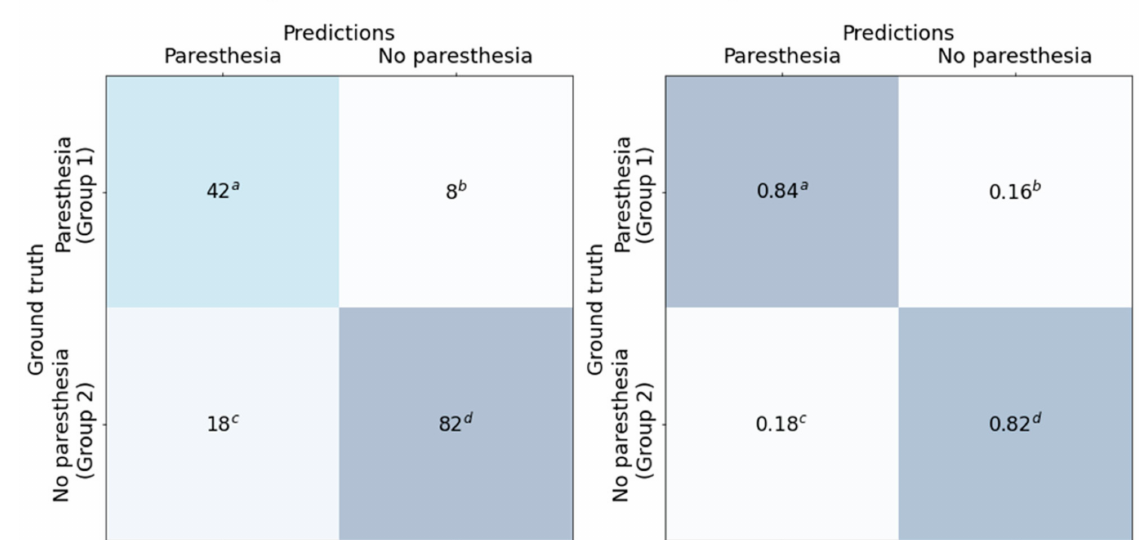
Figure 6. Classification results—confusion matrix. Prediction: Expected paresthesia to appear after extraction as a result of deep learning. Group 1: Paresthesia of inferior alveolar nerve actually appeared after mandibular third extraction. Group 2: No paresthesia of inferior alveolar nerve actually appeared after mandibular third extraction. a True positive. b False negative. c False positive. d True